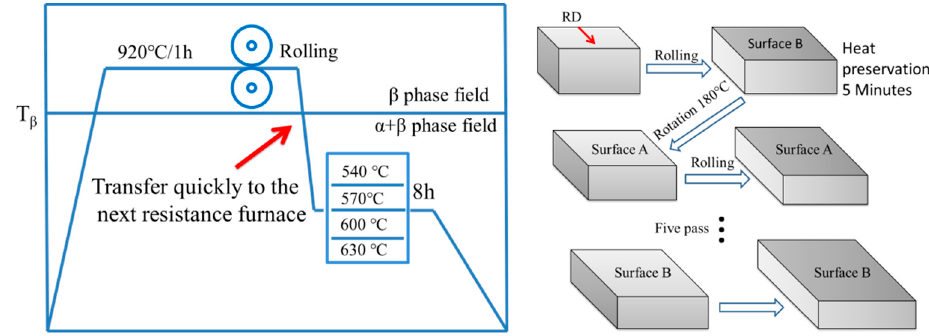
Figure 2. The rolling and heat treatment procedure of Ti17 alloy.